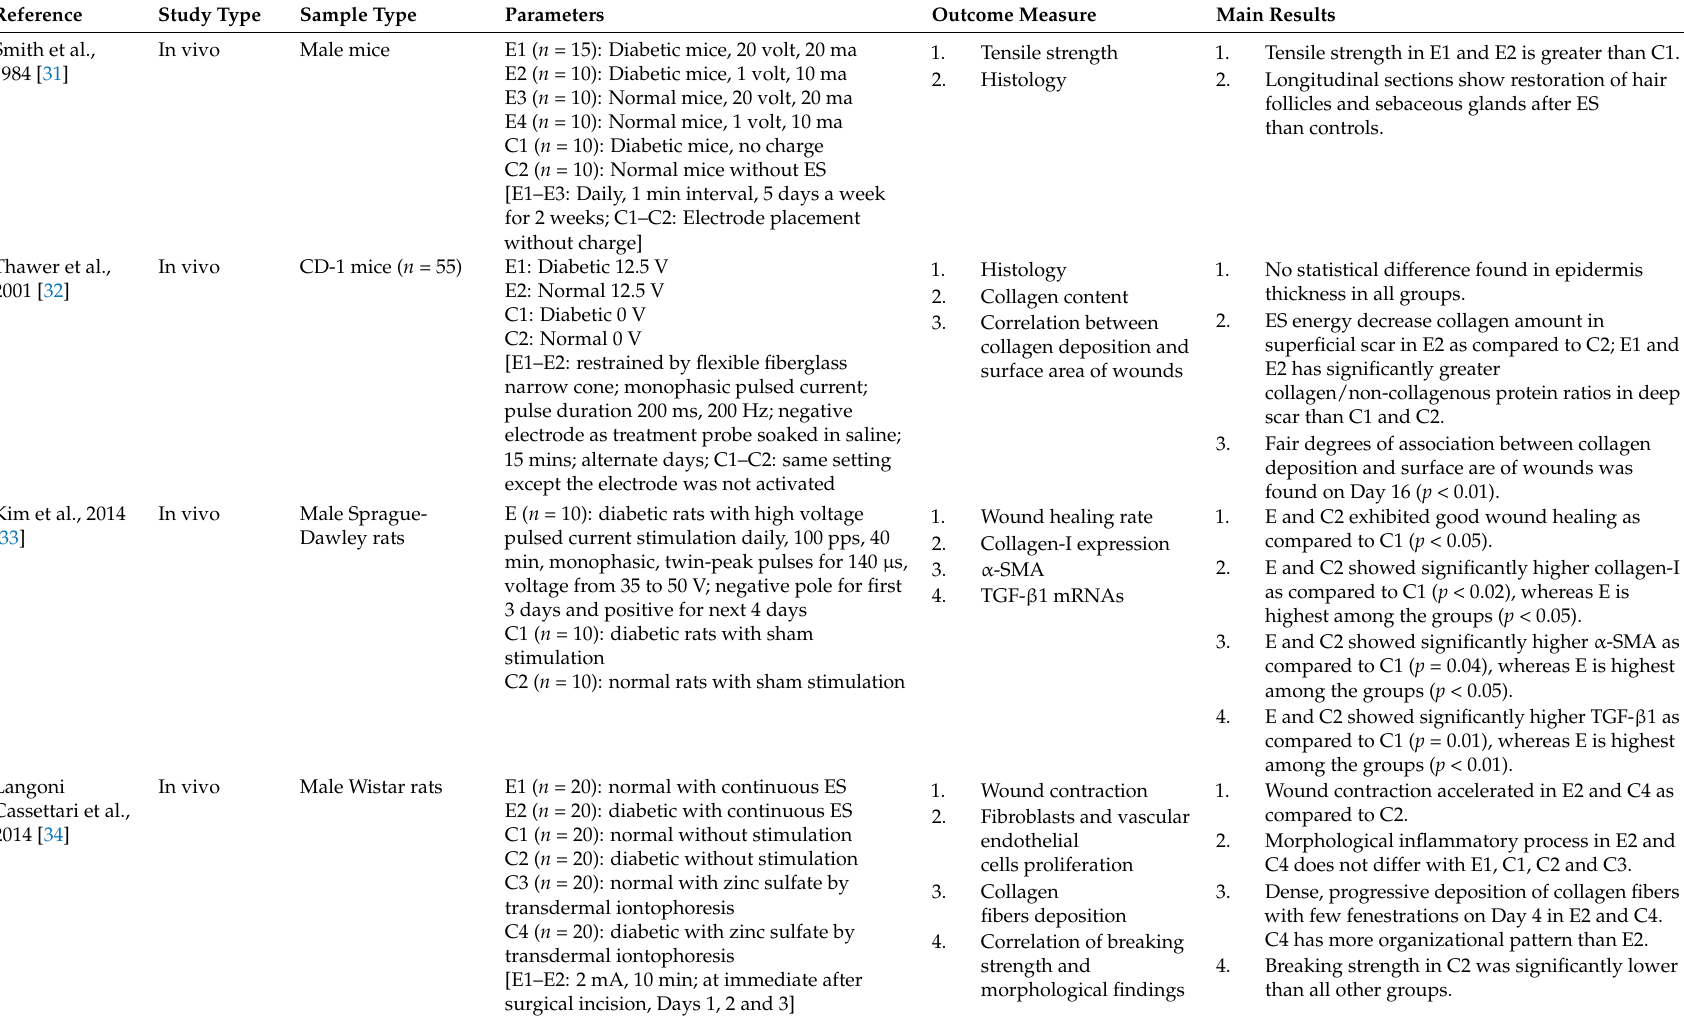
Table 4. Outcomes of ES energy for treating diabetic